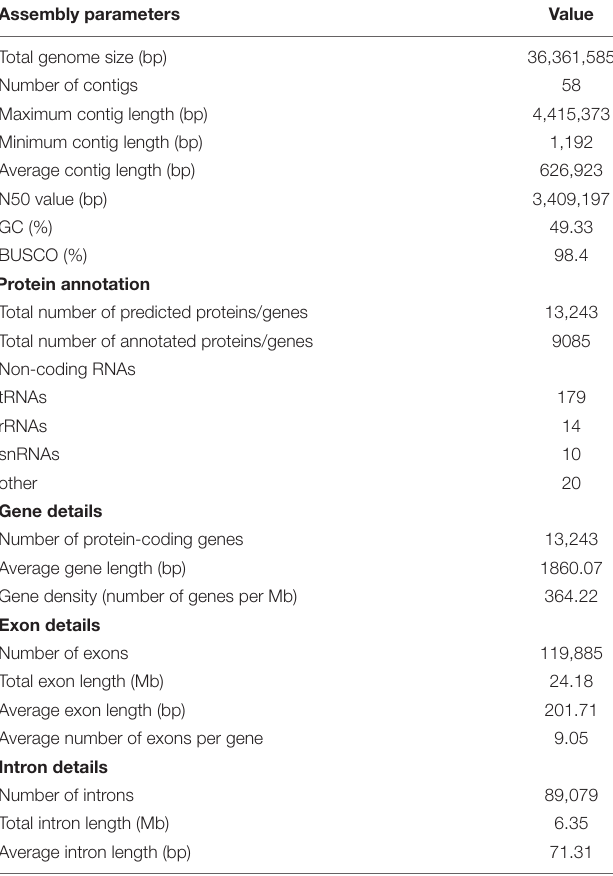
TABLE 2 | Whole-genome assembly features of C. lacerata CGMCC No.